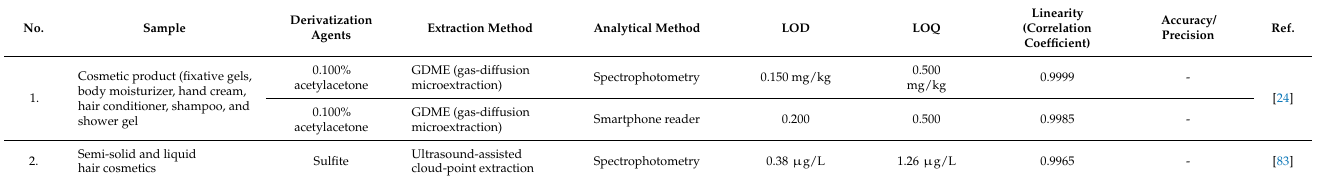
Table 3. Analytical method for determining formaldehyde in